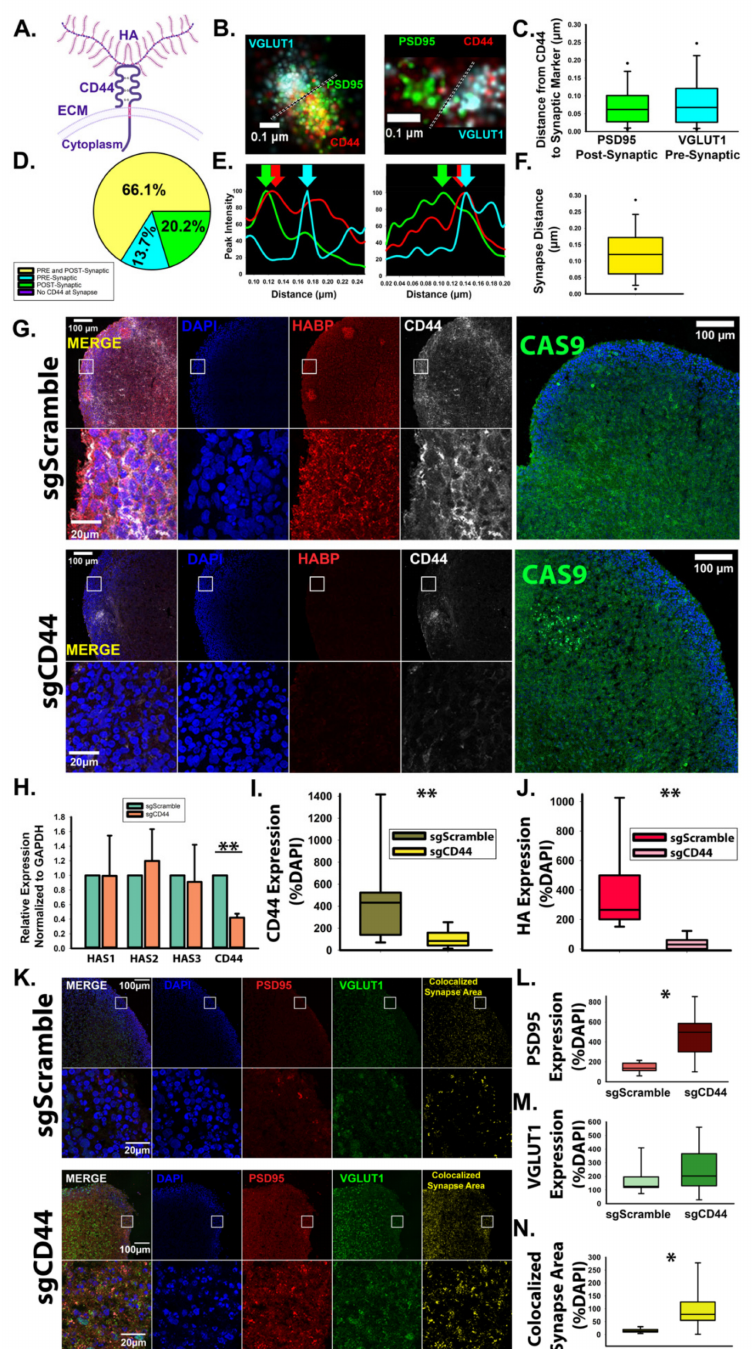
Figure 6. CD44 localizes to excitatory synapses and promotes HA retention in developing neural circuits. ( A ) Schematic of transmembrane protein CD44 bound to HA. ( B ) Representative dSTORM images of CD44 at excitatory synapses demonstrates that CD44 localizes to both pre- and post- synaptic compartments. Green: PSD95; red: CD44; cyan: VGLUT1. ( C ) Quantified distance from CD44 to pre- and post-synaptic markers. n = 168 synapses from 9 total spheroids derived from 3 separately grown spheroid sets. ( D ) Quantification of CD44 localization at individual excitatory synapses reveals that in the majority of cases, CD44 localizes to both the pre- and post-synaptic compartment (yellow) but may also be found solely within the pre- synaptic (blue) or post-synaptic (green) compartment. ( E ) Synaptic intensity plot profiles corresponding to the synapses shown in